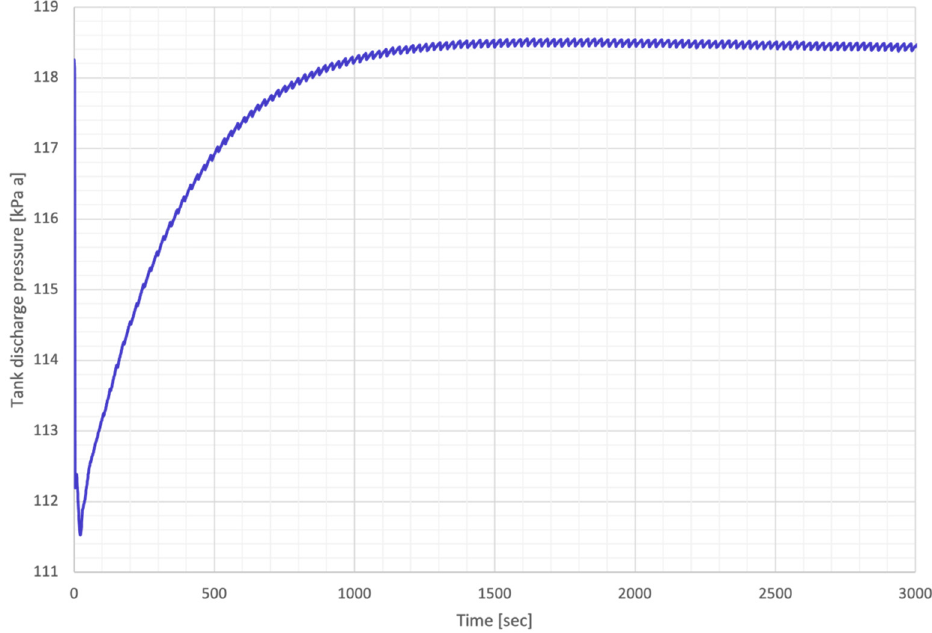
Figure 9. Tank discharge pressure.